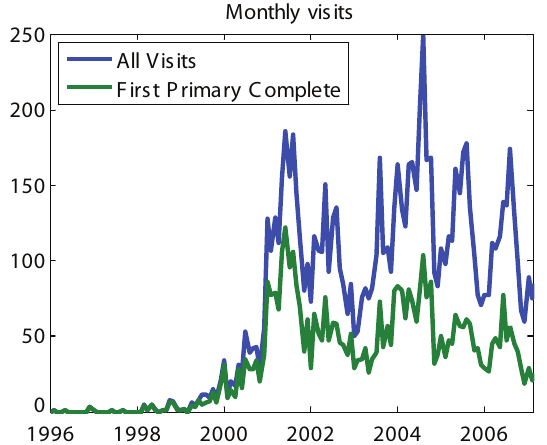
Fig. 6. Total number of degree confluence visits for each month since 1996. The upper curve shows all visits, the lower curve only first successful visits to primary